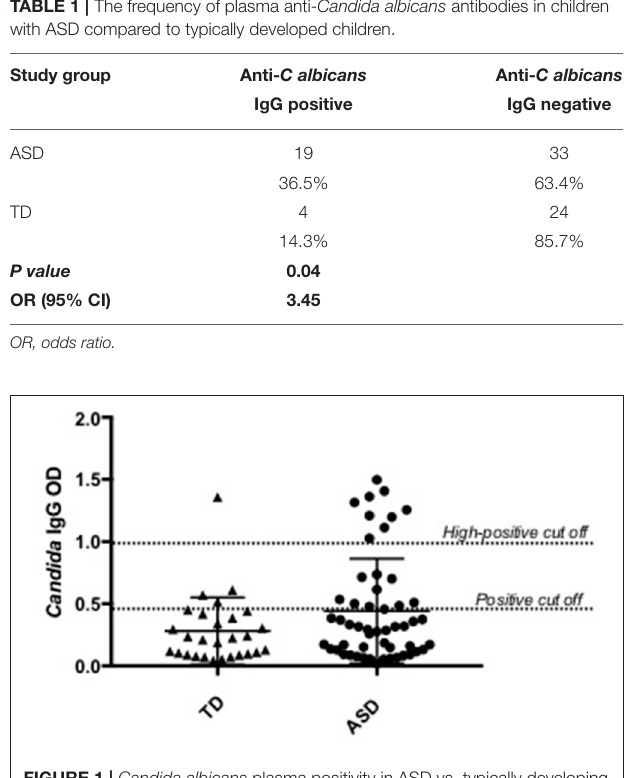
FIGURE 1 | Candida albicans plasma positivity in ASD vs. typically developing children. Nineteen children with ASD were positive for C. albicans IgG antibodies compared to four typically developing